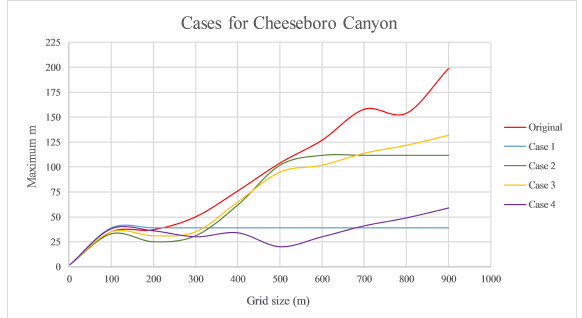
Figure 6. The m-value at which I Mr is maximum along a sequence from 1 m quadrats to the spatial extent for Cheeseboro is used to plot a curve of maximum m as a function of quadrat size in red. The four decomposition cases shown in Figure 3 are compared to the original Cheeseboro population data.